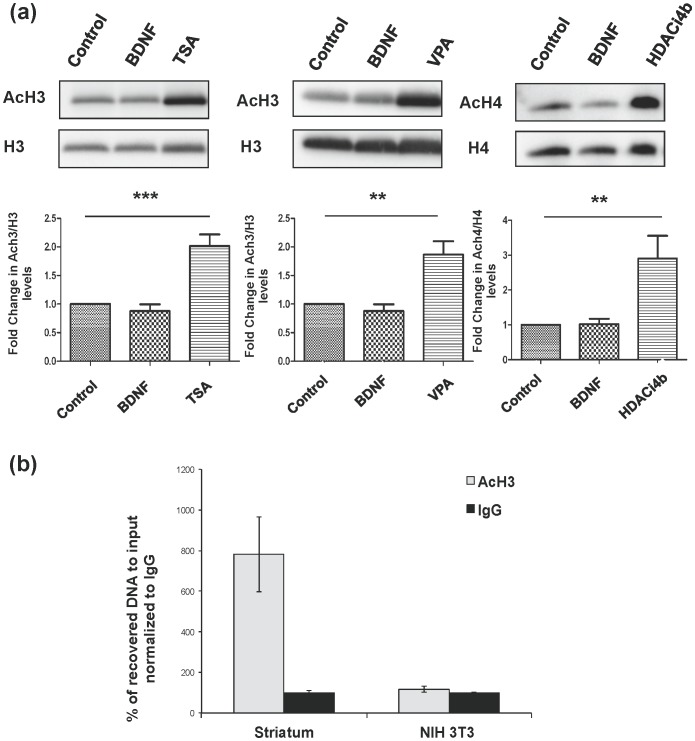
AcH3 is increased in striatal neurons by HDAC inhibitors and is enriched downstream of the transcription start site in Ppp1r1b striatal chromatin.(a) Cells were treated with BDNF (10 ng/mL), (a) trichostatin A (10 nM), (b) valproic acid (3 mM) or (c) HDACi 4b (5 µM) for 3 h. N = 3−5, +/− SEM (*p<0.05, ***p<0.001). (b) Chromatin was purified from adult mouse striatal tissue (STR) (DARPP-32-positive) and NIH-3T3 cells (DARPP-32-negative). Chromatin immunoprecipitation coupled with real-time PCR showed an increased association of acetylated histone H3 within a 1 kb region downstream of the DARPP-32 transcriptional start site (TSS) in striata relative to NIH 3T3 cells. Results are representative of two separate experiments performed in triplicates. Values for IgG are set at 100%. Error bars indicate SEM (*p<0.05).